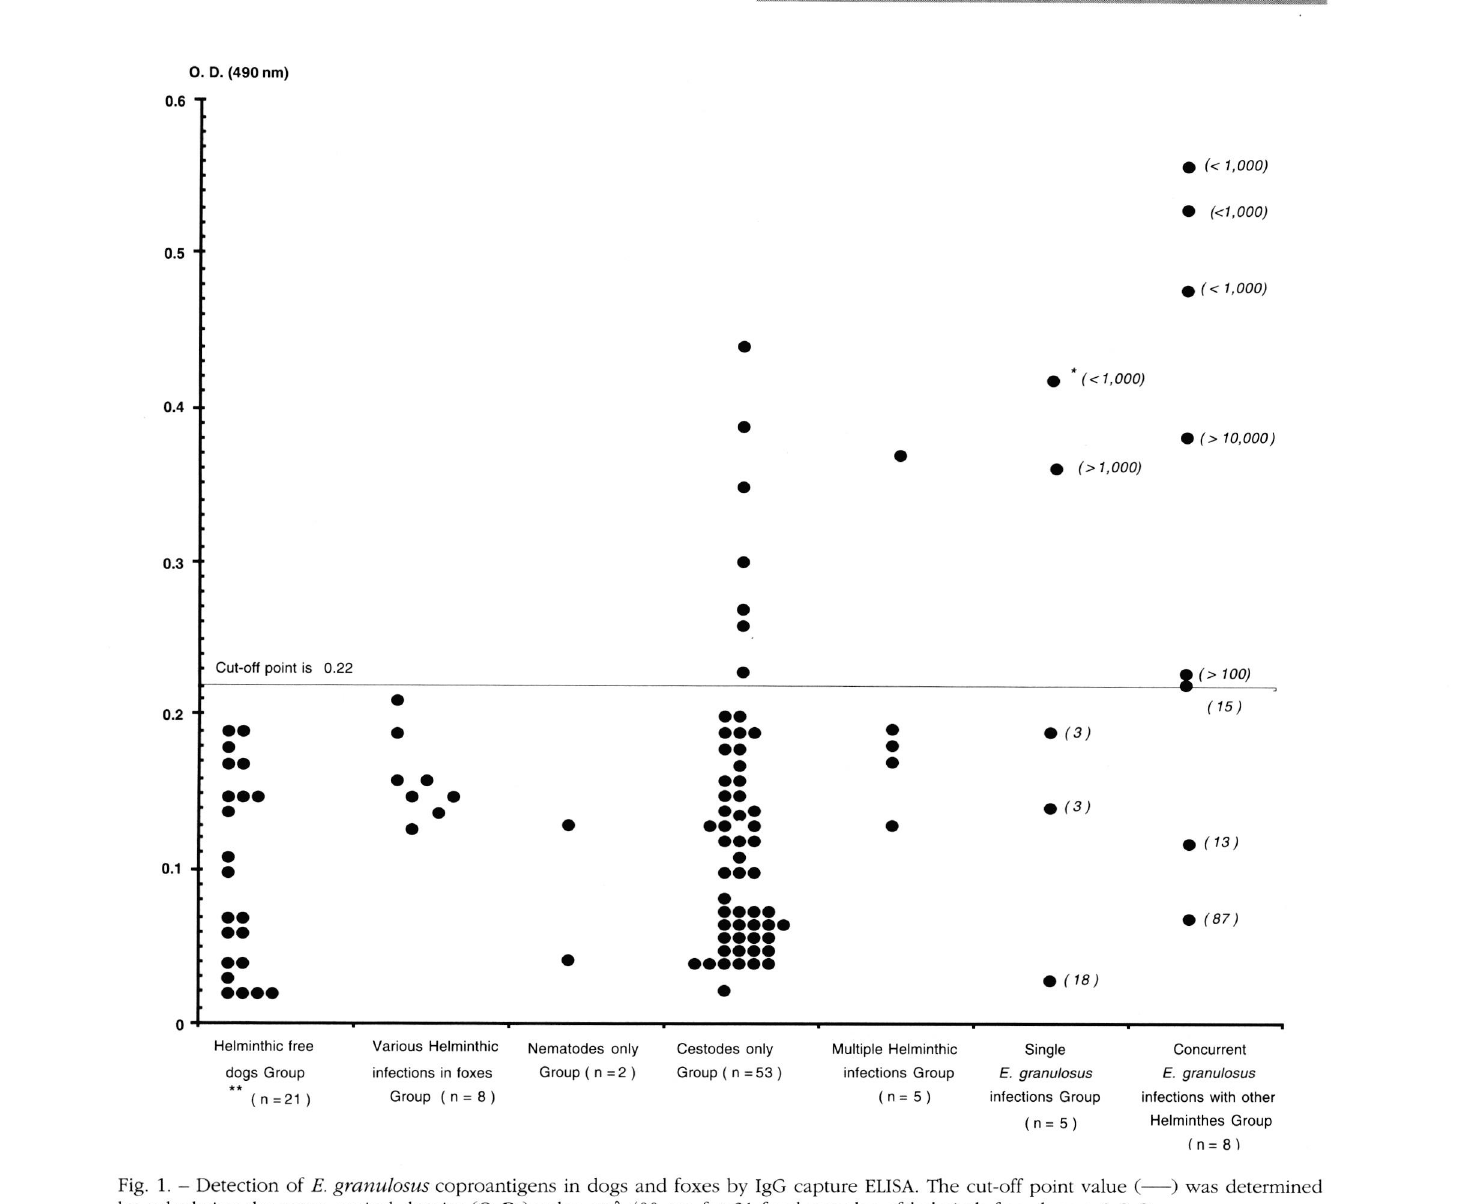
Fig. 1. - Detection of E. granulosus coproantigens in dogs and foxes by IgG capture ELISA. The cut-off point value (—) was determined by calculating the mean optical density (O. D.) value at A.490 nm for 21 fecal samples of helminth free dogs + 3 S. D. * Number in parenthesis indicates the worm burden of E. granulosus in infected dogs as determined by necropsy. ** Number in parenthesis denotes number of animals examined in each group.